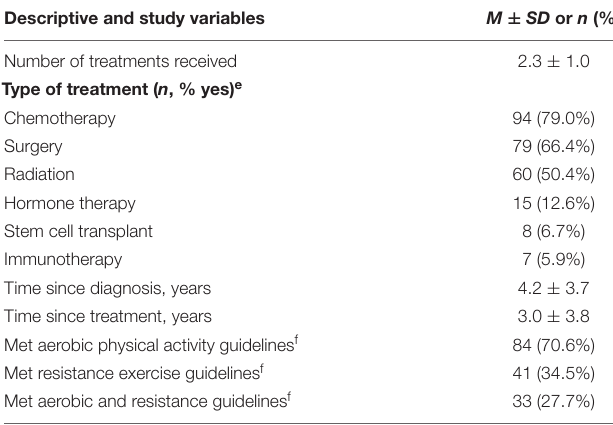
TABLE 1 | Participant descriptive characteristics ( n =